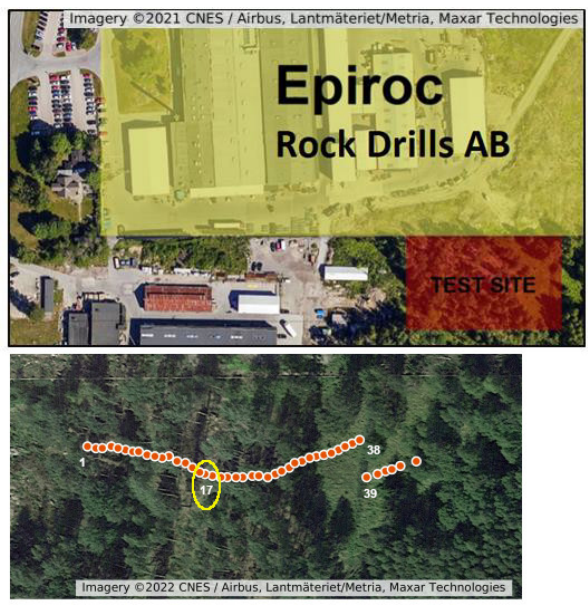
Figure 1. The test site next to the Epiroc factory in Örebro, Swe- den (upper figure), and the SWD acquisition geometry for the data presented in this study consisting of 44 1C geophones and the rig (marked with DB) located near station 17 (lower figure). The maps were made with © Google My